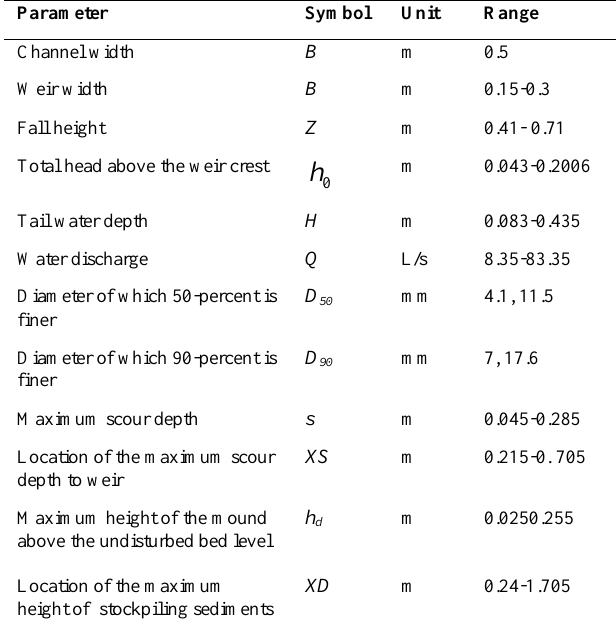
Table 1. Changes in range of parameters used in